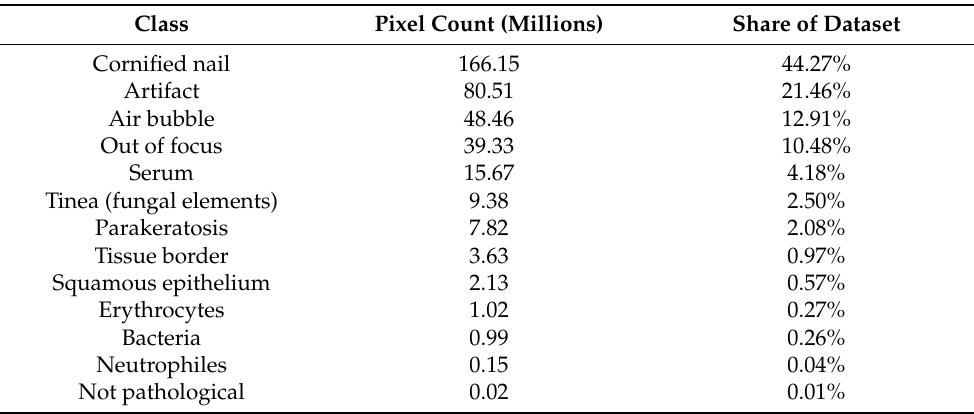
Table 1. Class distribution of training set after